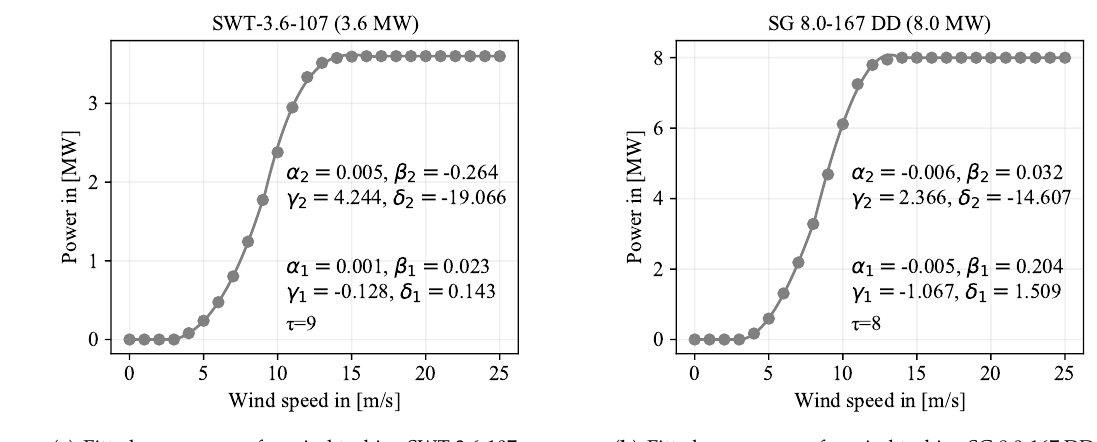
Figure 3. Power curves and specific parameters of the two turbine types installed at Gwynt y Mor (SWT-3.6-107) and Kriegers Flak (SG 8.0-167